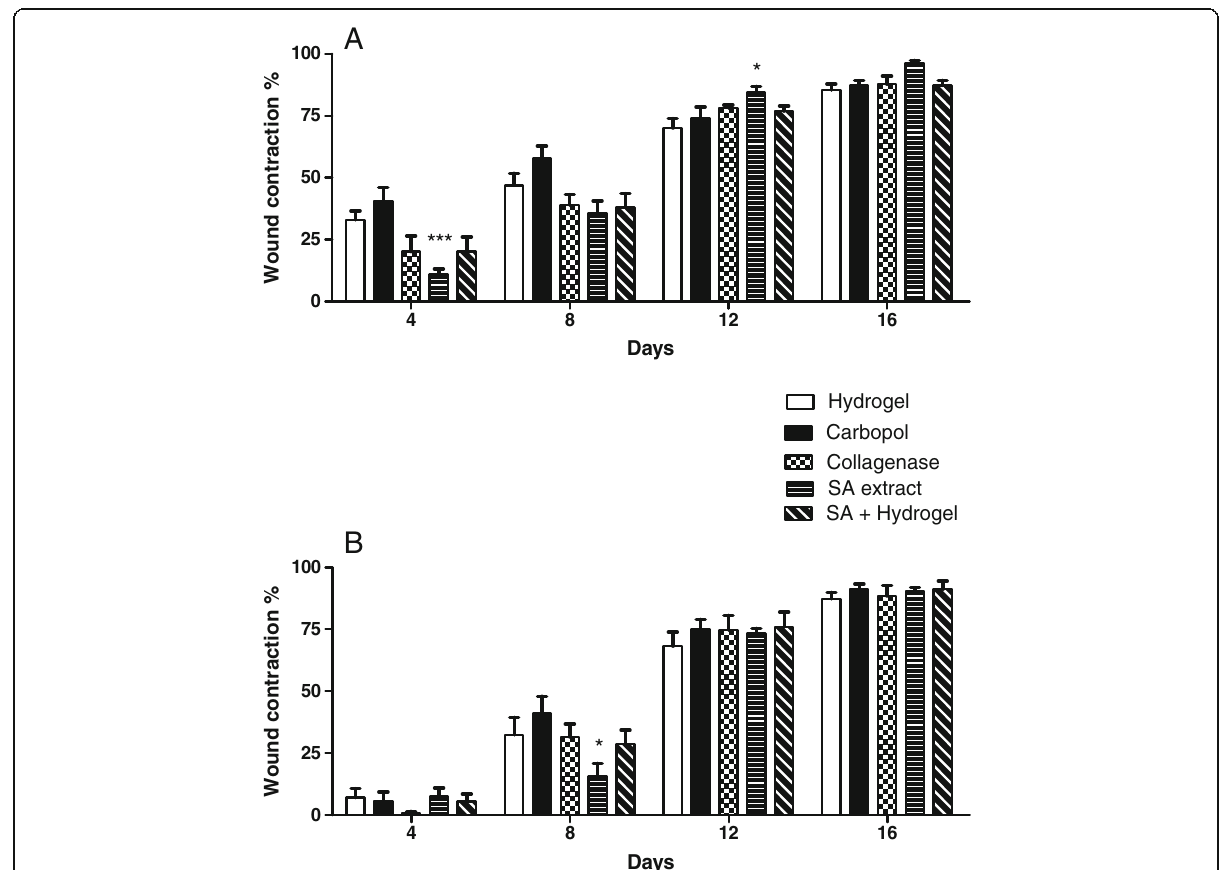
Fig. 3 Cutaneous wound contraction measurements in the non-diabetic animals ( a ) and in the diabetic animals ( b ) on days 4, 8, 12, and 16. Each column represents the mean ± standard error of 5 – 7 animals. * p < 0.05, *** p < 0.001 represents the significance level in comparison to the Hydrogel group (Two-Way ANOVA, followed by Bonferroni ’ s